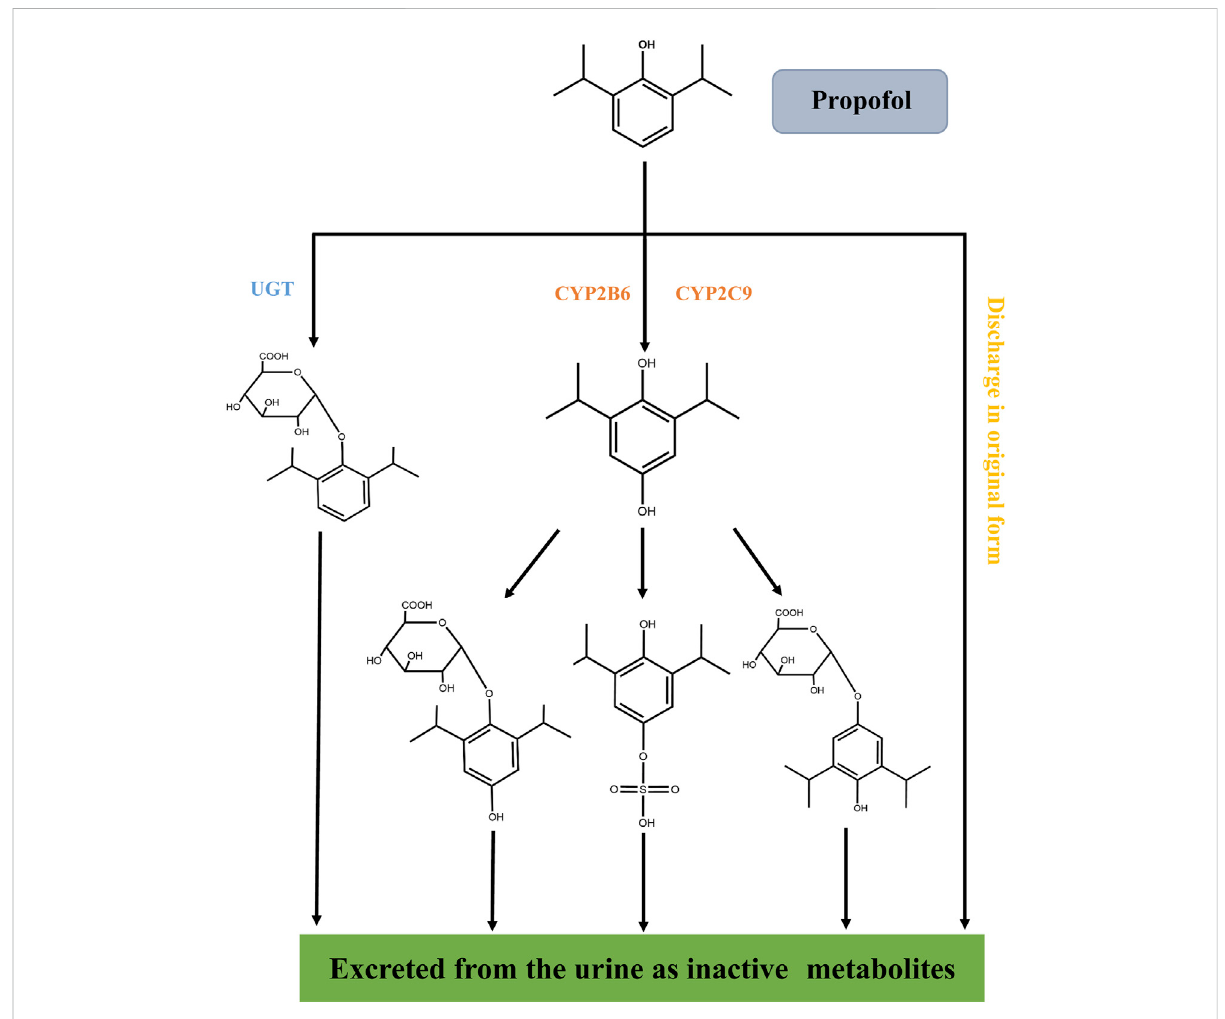
FIGURE 3 Metabolic process of propofol in vivo . Propofol is rapidly metabolized into inactive compounds in the liver through the hydroxylation of cytochrome P450 (CYP2B6 and CYP2C9) isomers and the UDP-glucuronosyhransferase (UGT) pathway and excreted by the kidney. Less than 1% of propofol is excreted in urine and 2% in